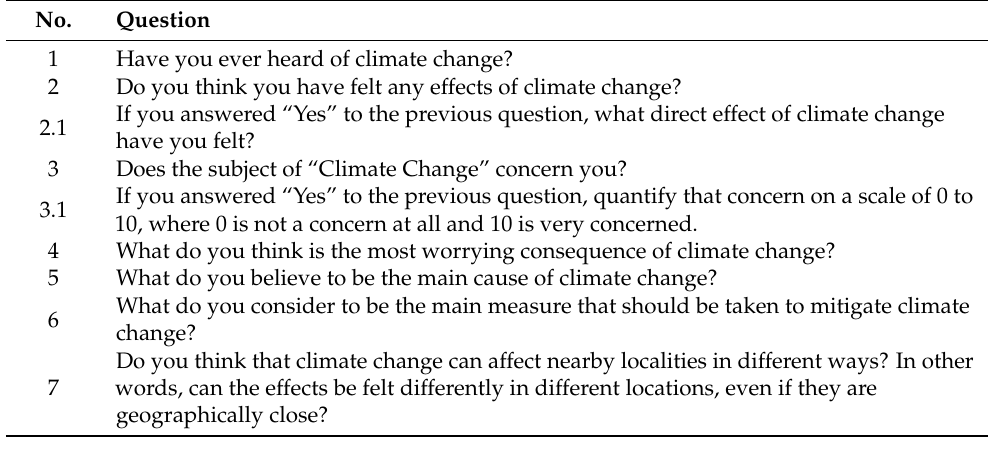
Table 1. Survey carried out to assess the level of concern about the impacts of climate